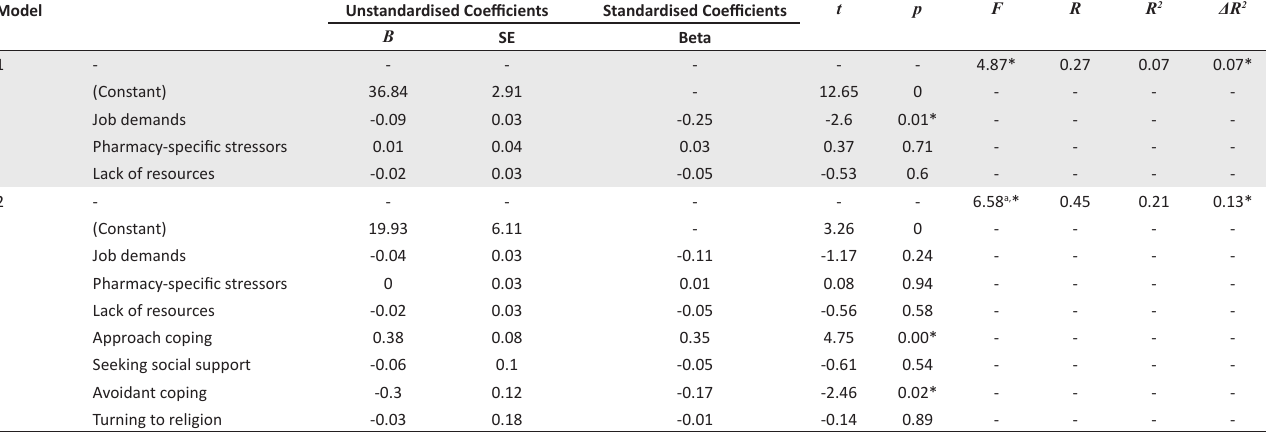
TABLE 5: Multiple regression analysis with work engagement as dependent variable.